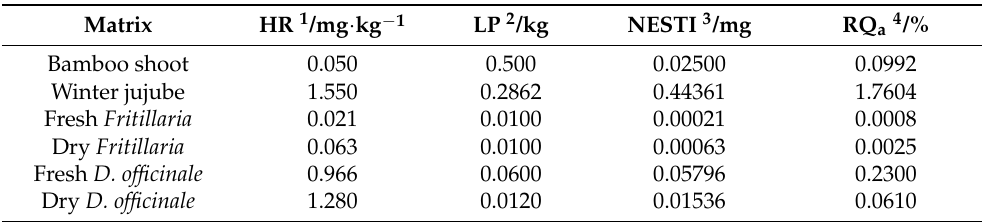
Table 5. The short-term dietary risk assessment of imidacloprid in bamboo shoot, winter jujube, fresh and dry D. officinale , and fresh and dry Fritillaria